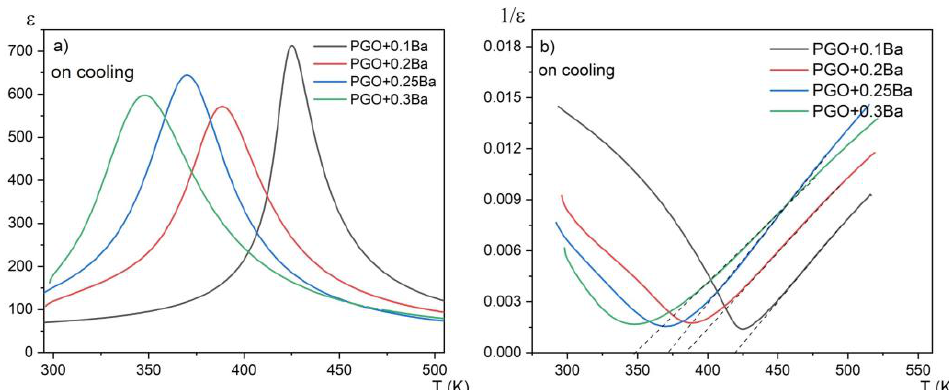
Figure 2. ( a ) temperature dependences of the real part of the linear dielectric susceptibility for PGO + 0.1Ba, 0.2Ba, 0.25Ba, and 0.3Ba; ( b ) temperature dependences of the reciprocal of dielectric susceptibility for PGO + 0.1Ba, 0.2Ba, 0.25Ba, and 0.3Ba on cooling. Dashed lines represent compliance with the Curie–Weiss law.